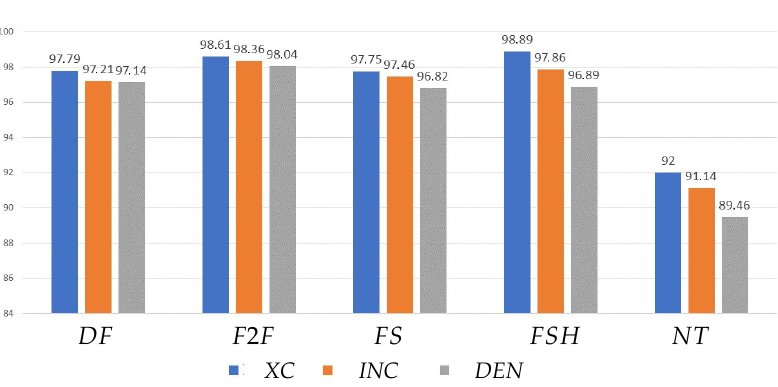
Figure 2. Accuracy of different networks in the pre-social